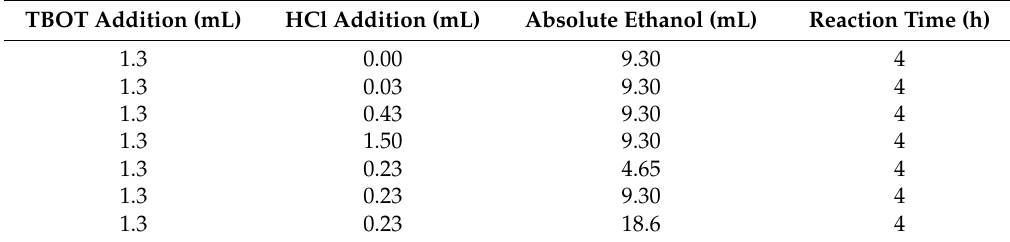
Table 1. TiO 2 microspheres (Ms) samples synthesized with chemical reagents and reaction time in the